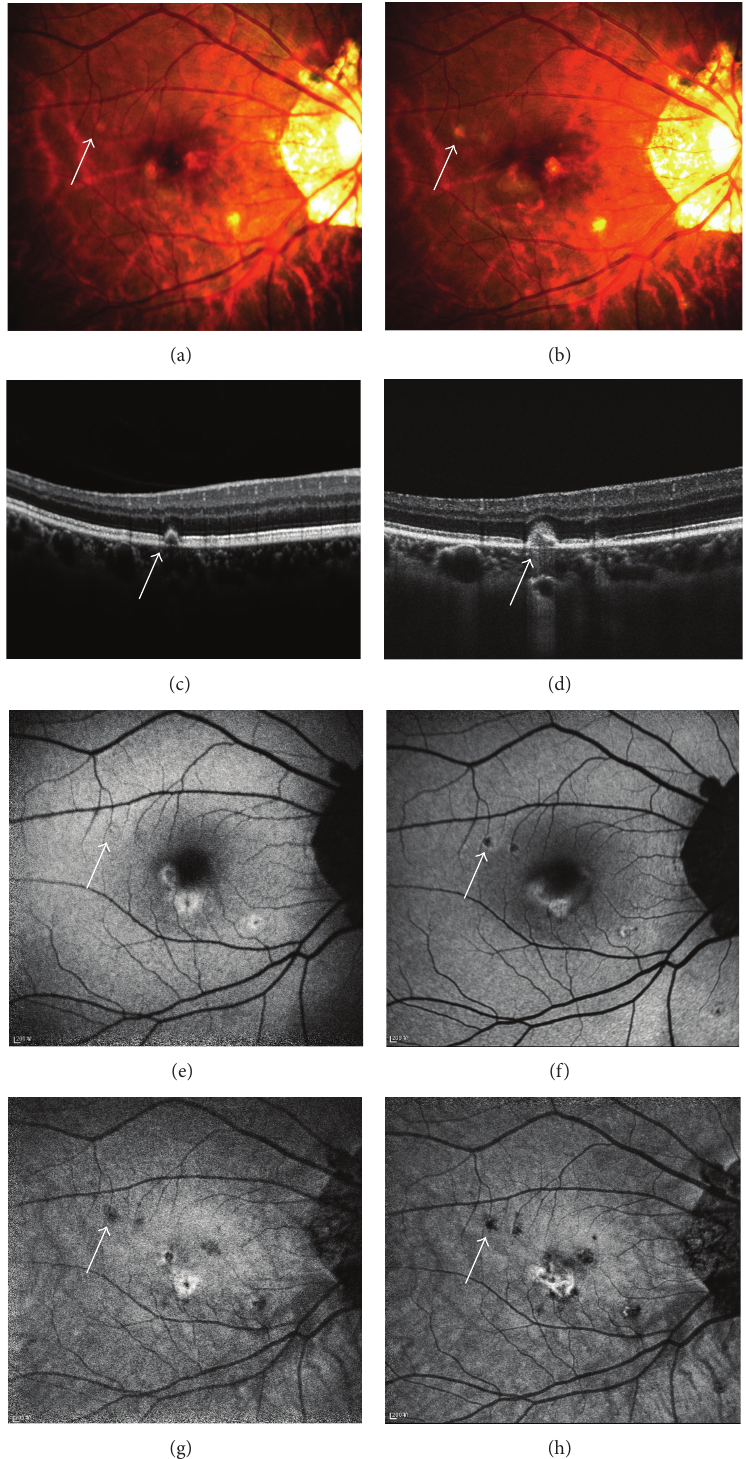
Figure 2: Figure 2: The presence of hypoautofluorescent spot without hyperautofluorescent margin on FAF (e, f, g, and h) and corresponding findings on fundus photography (a, b) and SD-OCT (c, d). (a) A spot with slight discoloration presented on fundus photography. (b) A sub-RPE nodule was shown on SD-OCT, penetrating BM to lift the RPE. A hypoautofluorescent lesionwasmore distinctively shown on NIR-FAF (g) compared to SW-FAF (e). (b) Eleven weeks later, the spot became larger on fundus photography. (d) The chorioretinal nodule on SD-OCT broke through RPE and BM, reaching the OPL. (f) The hypoautofluorescent spot on SW-FAF became more distinctive, with hyperautofluorescent margin around. (h) The hypoautofluorescent spot on NIR-FAF became